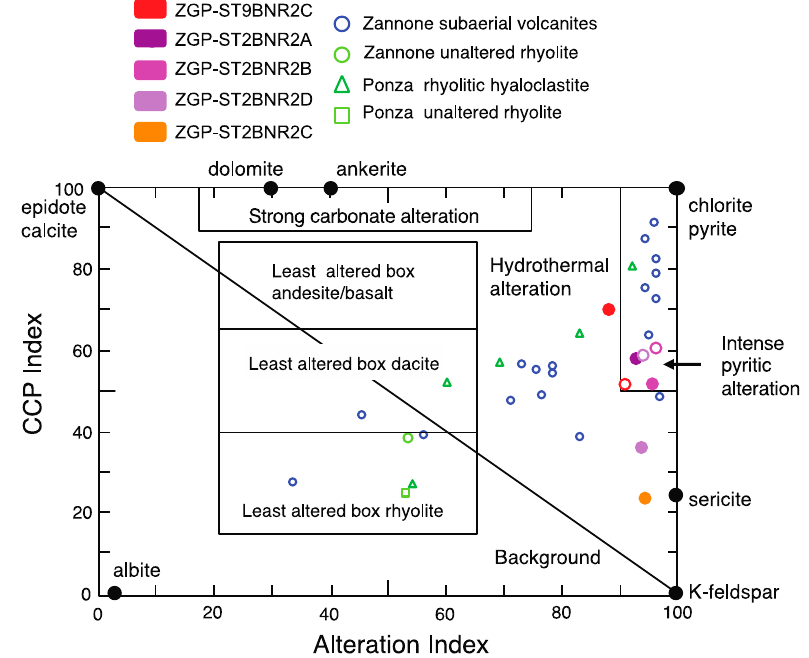
Figure 11. Alteration box plot with the Ishikawa alteration index (AI [25]) plotted against the chlorite–carbonate–pyrite index (CCPI; diagram after [23]). Symbols ZGP clasts: full—inner portion, empty—outer portion. Zannone subaerial volcanites are from Conte and Dolfi [26]; Zannone and Ponza unaltered rhyolites are samples s5 and s13 in Conte et al. [28]. Data representative of unaltered and weak to intense altered rhyolitic hyaloclastite from Ponza (argillitic, propylitic, silicic, and sericitic zones) are from Altaner et al. [27].